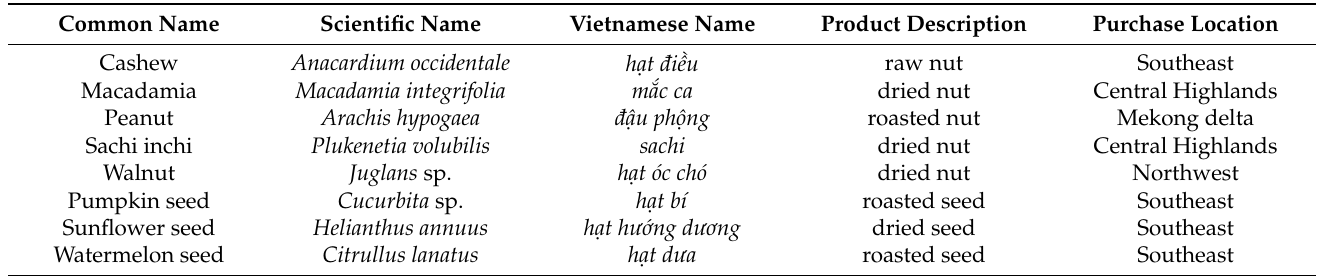
Table 1. Summary of the nuts and seeds examined in the